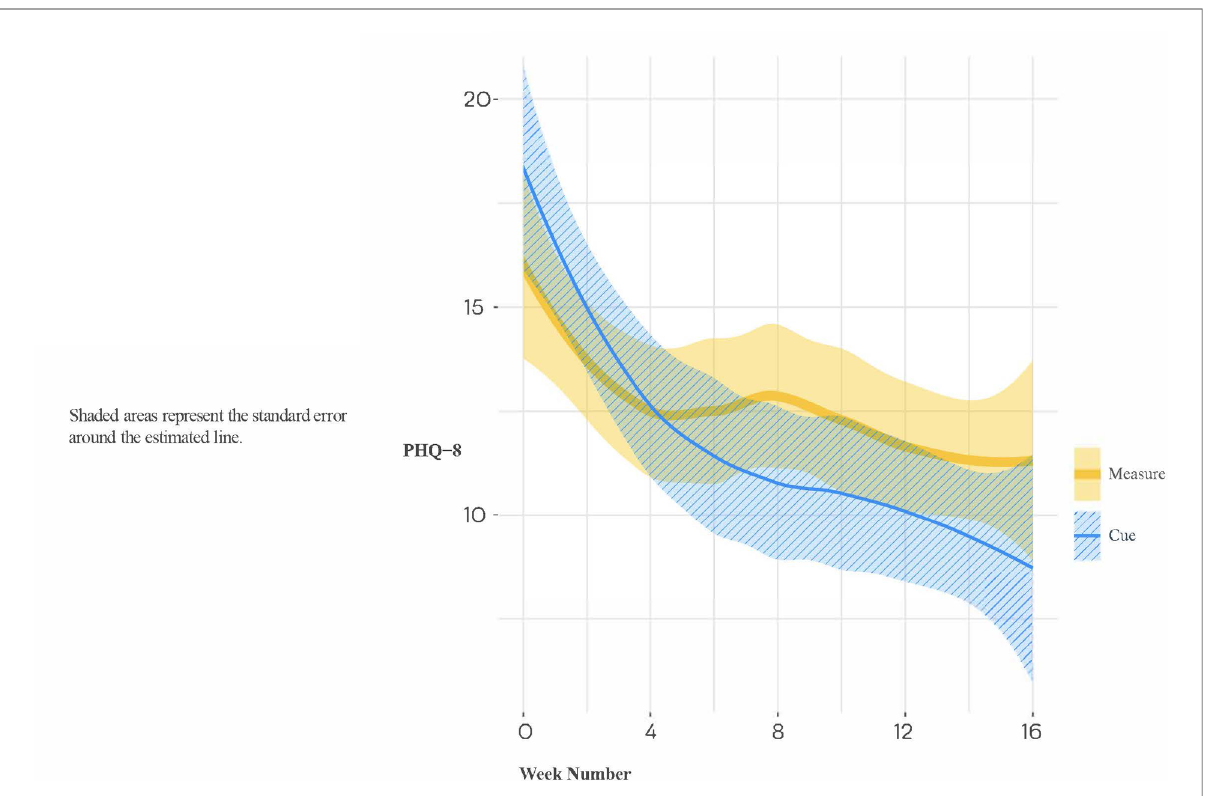
FIGURE 7 Loess trajectories of PHQ-8 for Cue and measure (control) conditions in depressed-at entry participants (initial PHQ-8 ≥